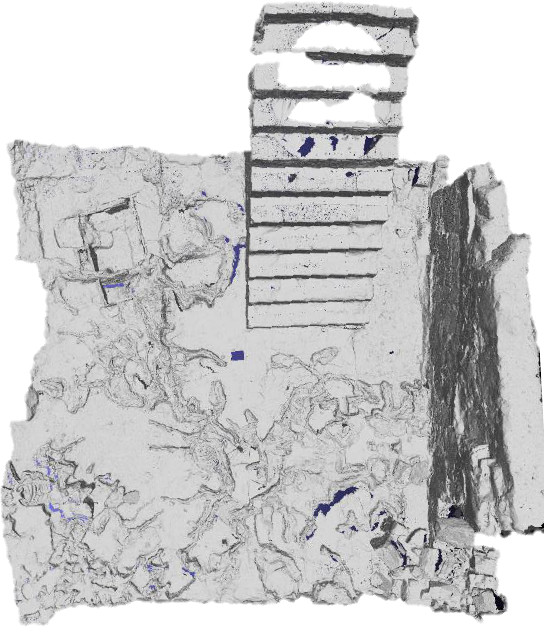
Figure 4. Image of the 3-D scan of a fragment of the courtyard of the Casas del Turuñuelo site (Guareña, Badajoz) where it was possible to document part of the northern wall, the staircase, and the animal sacrifice documented on the